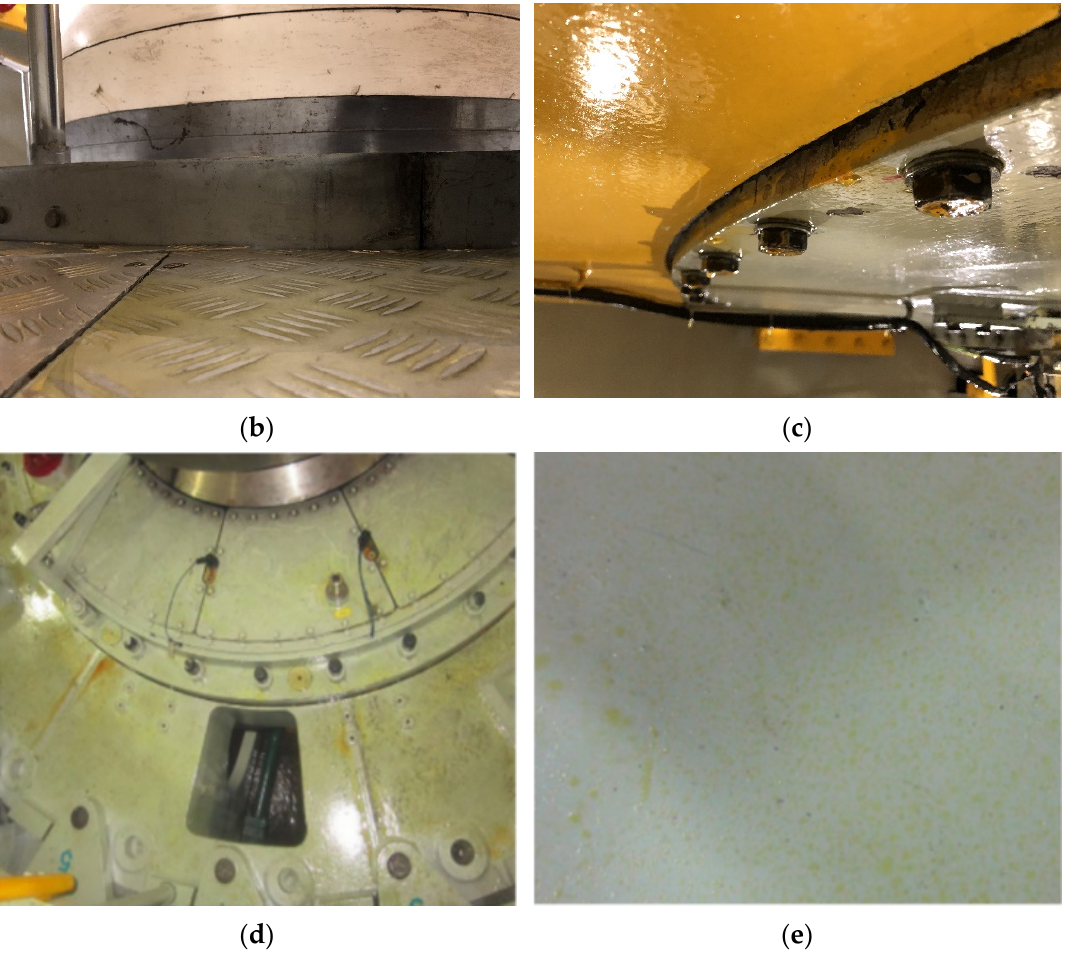
Figure 5. Oil mist leakage photos for different scenarios. ( a ) Water pollution caused by oil leakage at Balimela Hydropower Station [25]; ( b ) oil mist attached to the lower guide maintenance platform; ( c ) oil mist attached to the lower frame; ( d ) oil mist accumulated on the top cover; ( e ) oil droplets accumulated on the turbine guide bearing cover.